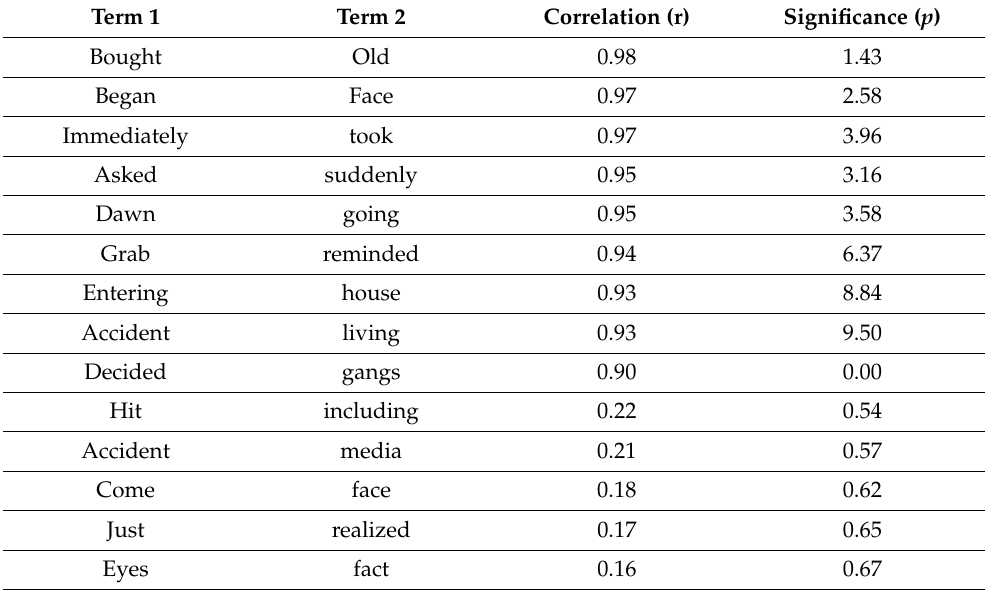
Table 11. Correlational Significance for Storyboarding (Source: Voyant Tools). Term 1 Term 2 Correlation (r) Significance ( p